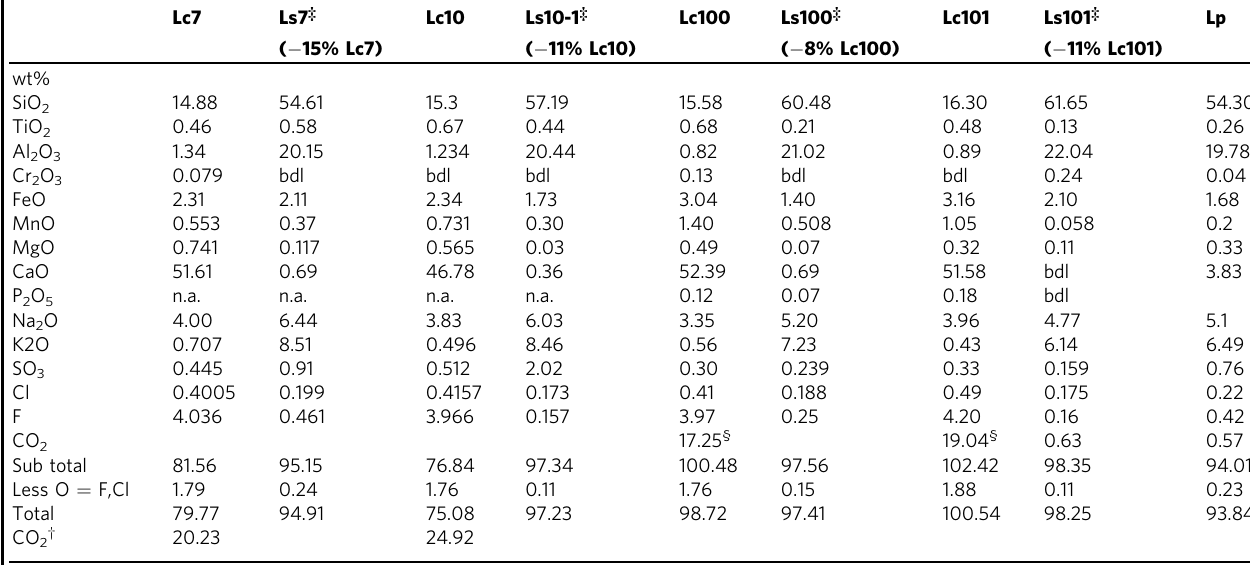
Table 1 Selected electron microprobe analyses of conjugate immiscible silicate (Ls) – carbonate (Lc) melts. Lc7 Ls7 ‡